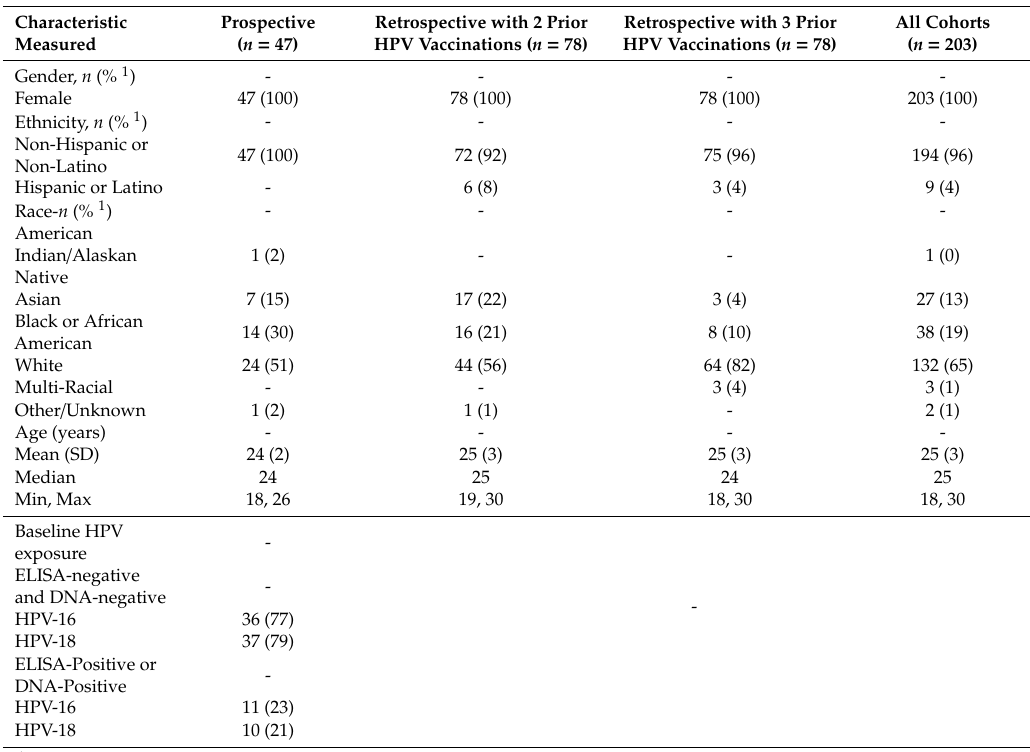
Table 1. Demographic and baseline human papillomavirus virus (HPV) exposure characteristics of subjects in prospective and two retrospective